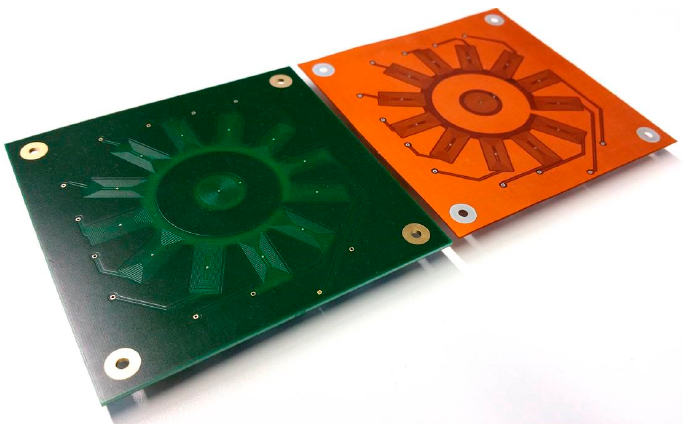
Figure 8. Rigid ( left ); and flexible ( right ) PCB based eddy current sensor array.